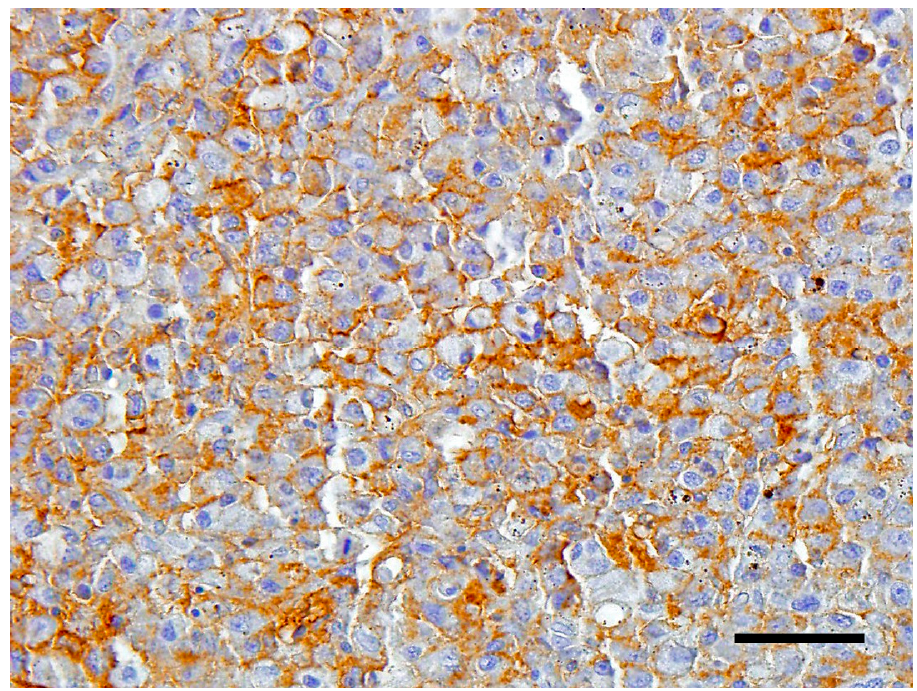
Figure 4. Photomicrographs of CD18 immunocytochemistry of tumor cells. 3,3 ′ -diaminobenzidine chromogen with hematoxylin counterstain; bar = 50 µm.